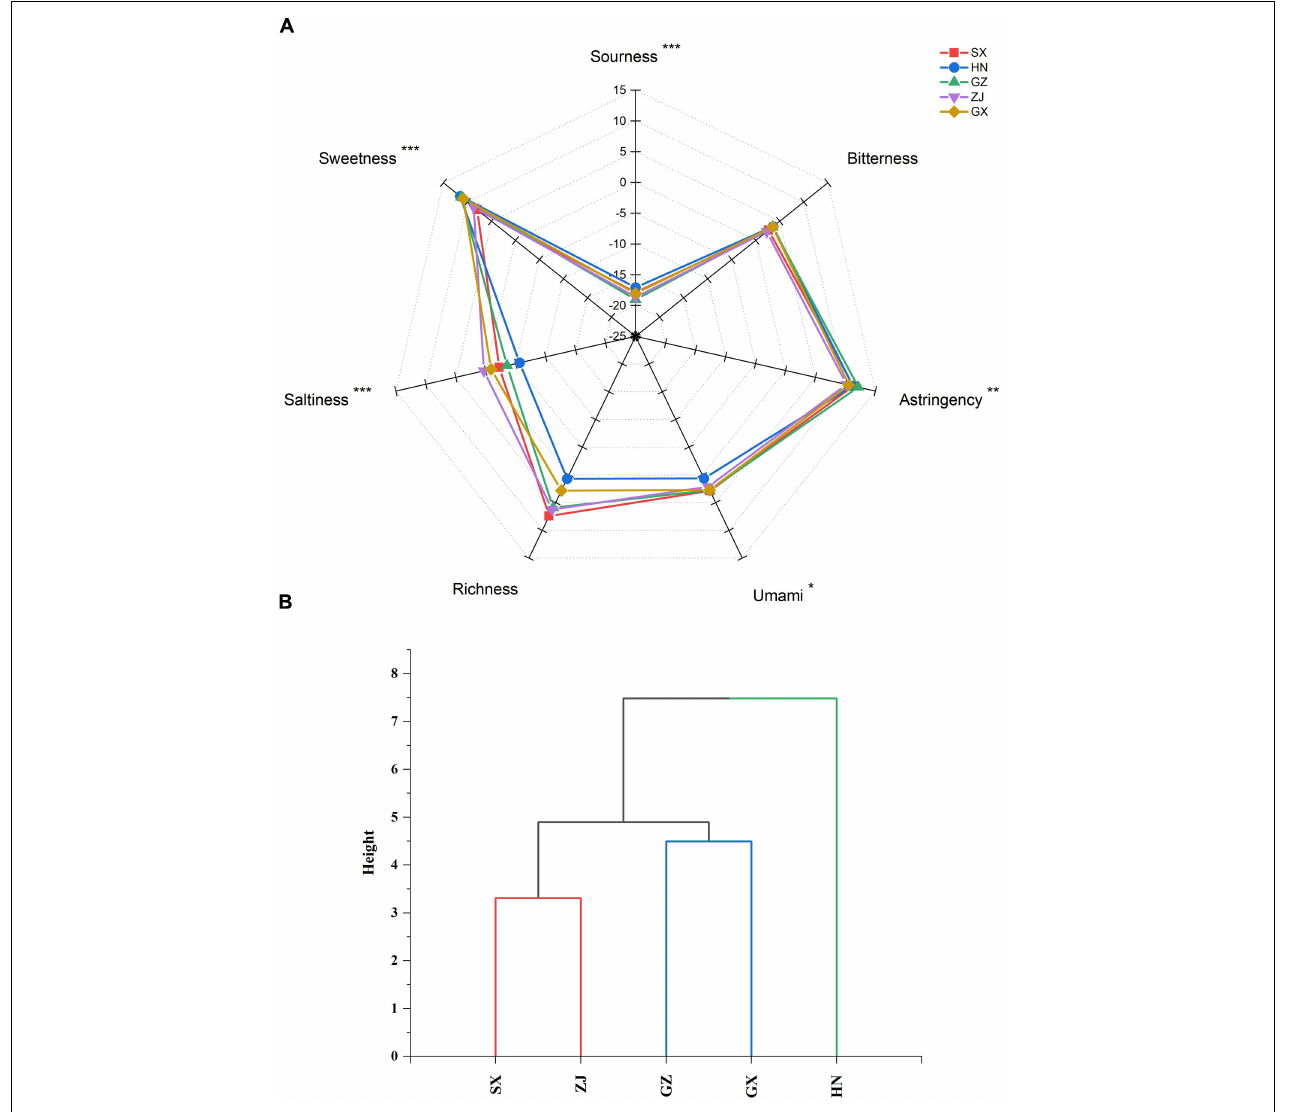
FIGURE 9 | Spider plot (A) and dendrogram plot (B) of the taste characteristics of five Fu brick teas in different regions evaluated by E-tongue. * p < 0.05, ** p < 0.01, *** p <